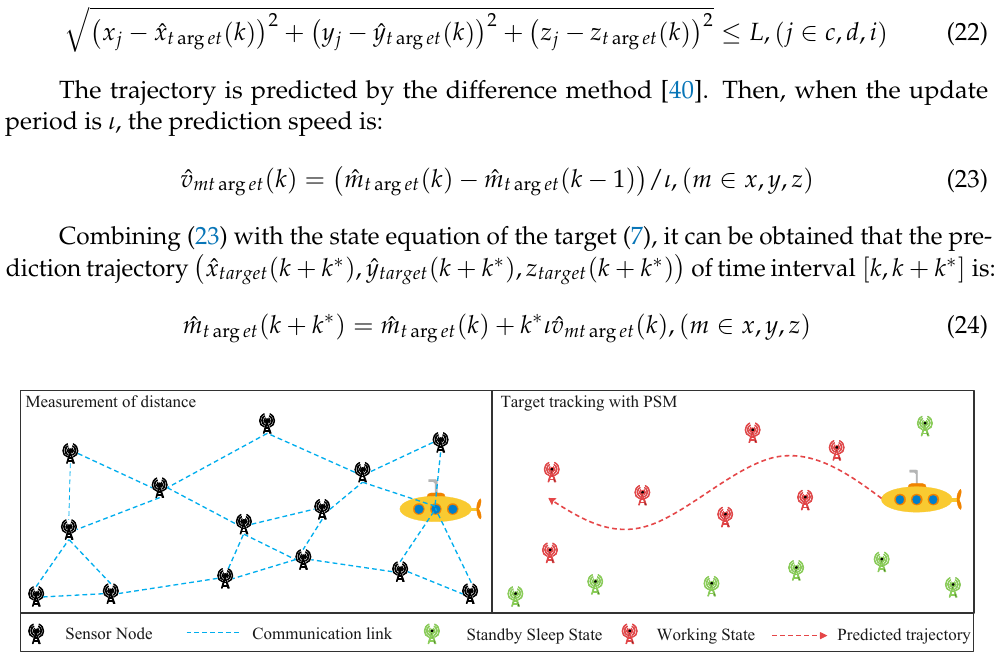
Figure 10. PSM Figure 10.